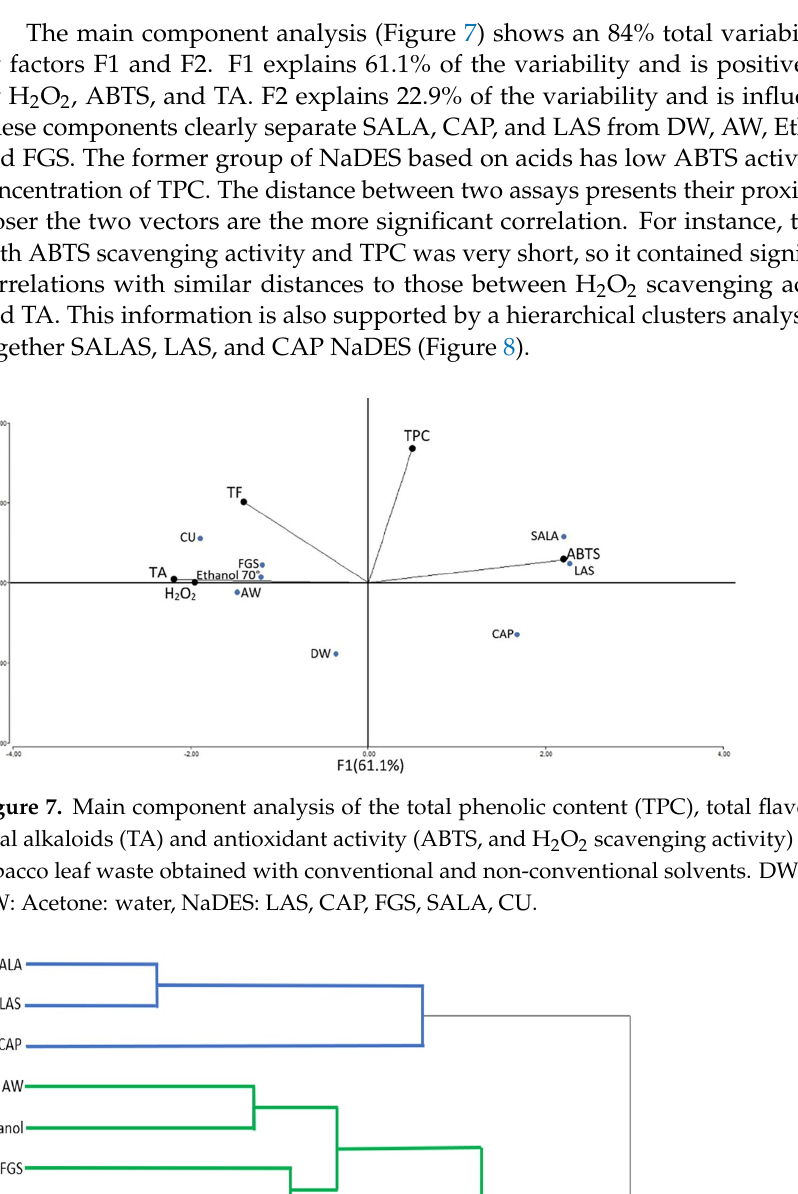
Table 6. Pearson’s correlation coefficients of ABTS and H 2 O 2 scavenging versus TPC, TF, and TA.